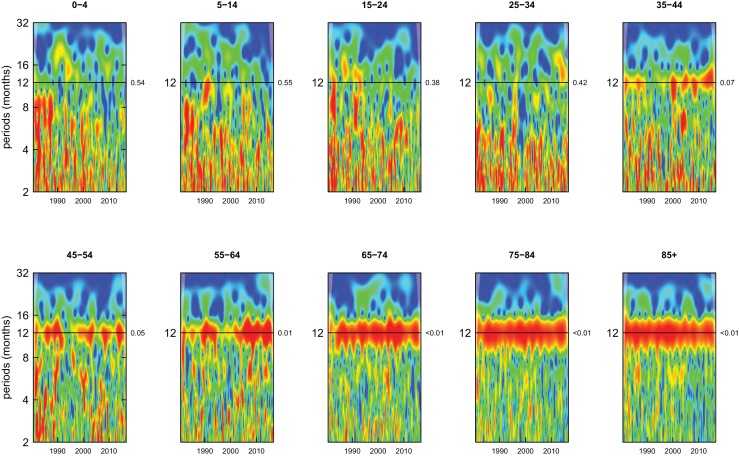
Wavelet power spectra for national time series of genitourinary disease death rates for 1980–2016, by age group for males.Wavelet power values increase from blue to red. The shaded regions at the left and right edge of each box indicate the cone of influence, where spectral analysis is less robust. P-values for the presence of 12 month seasonality are to the right of each figure at the 12 month line.